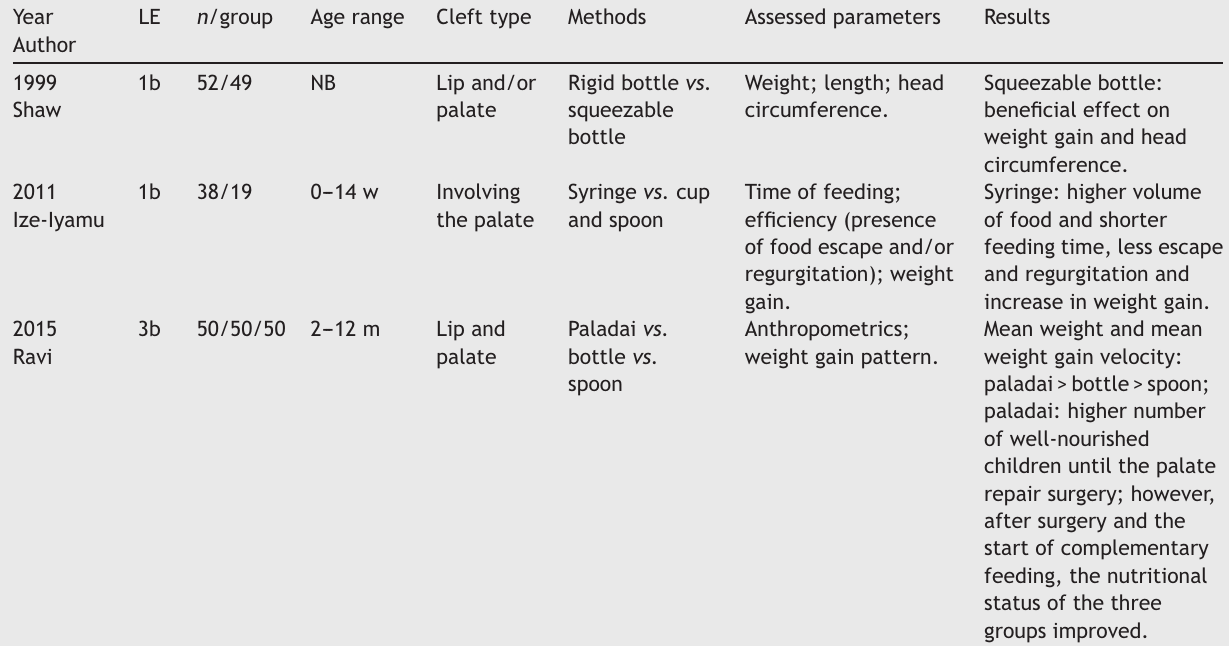
Characterization of studies comparing feeding methods in the preoperative period of surgical